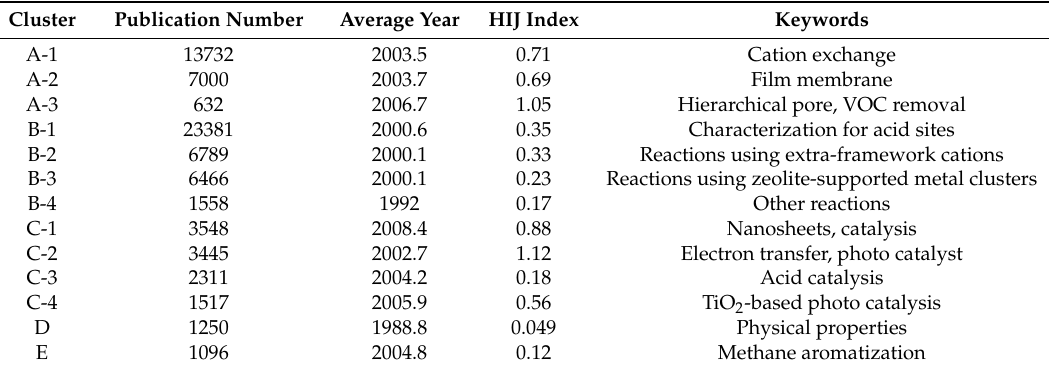
Table 1. High impact areas of research for zeolites.